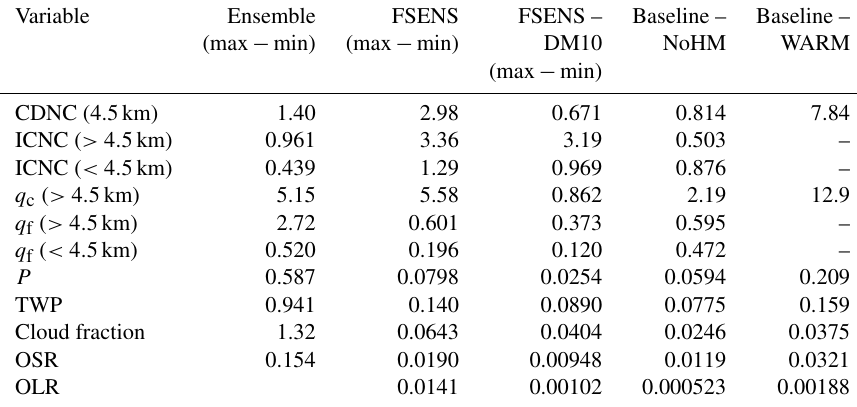
short-wave (OSR) and long-wave (OLR) radiation. Variable FSENS Baseline